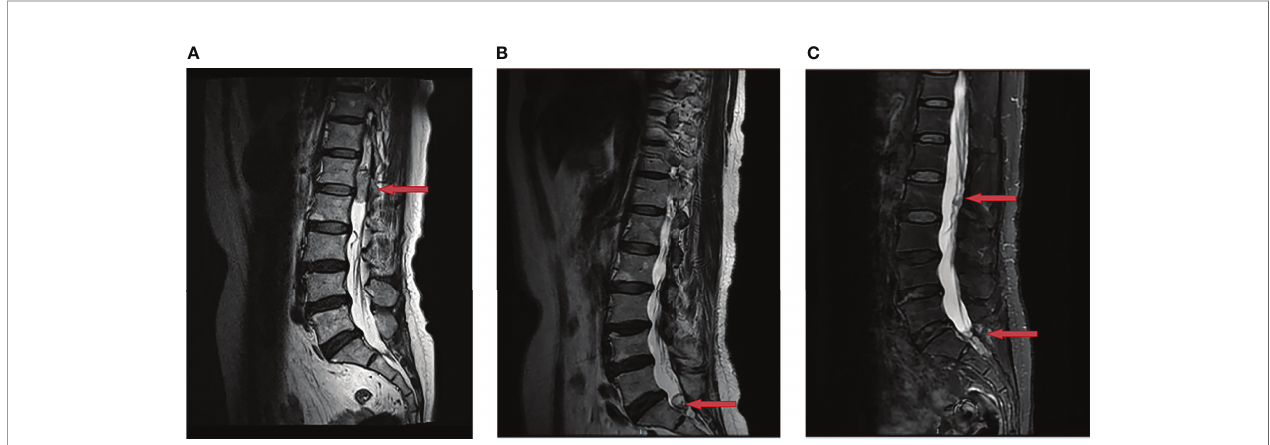
FIGURE 1 | Changes of hemangioblastoma of the magnetic resonance imaging (MRI). (A) A space-occupying lesion at L1-L2 was detected (red arrow) in May 2016; (B) A recurrent site at S1 was observed (red arrow) after the fi rst surgery in July 2019; (C) Two recurrent sites at L2 and S1-S2 were discovered (red arrow) after the second surgery in June